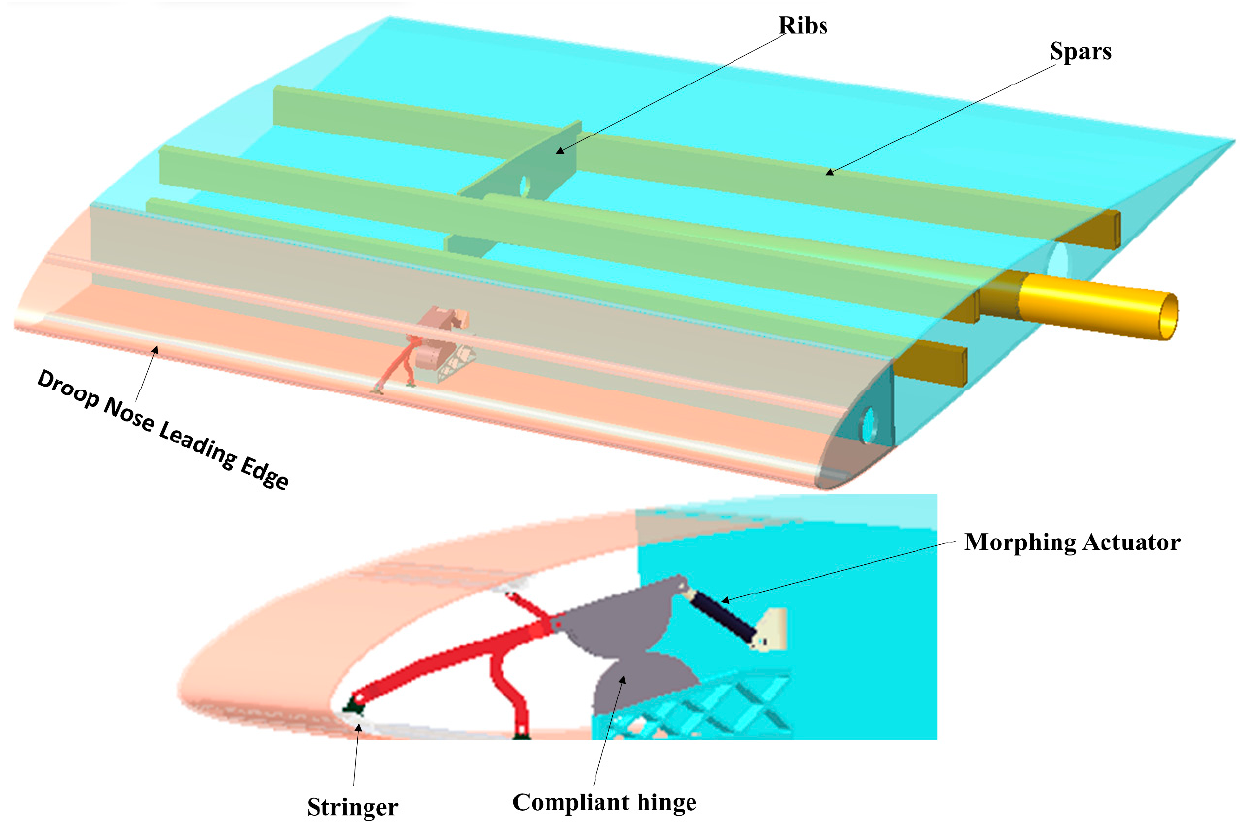
Figure 1. DNLE Morphing wing model.